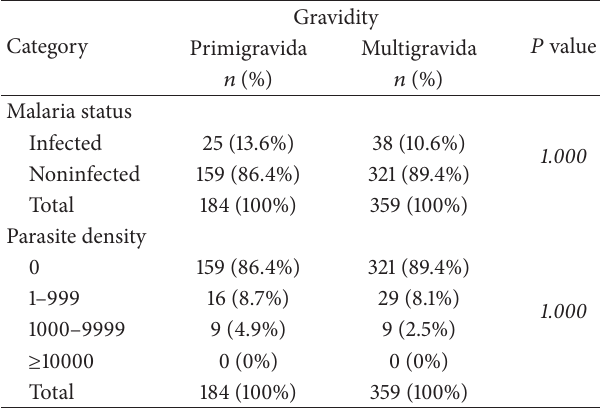
Table 2: Comparison of malaria parasite density between primi- gravidae and